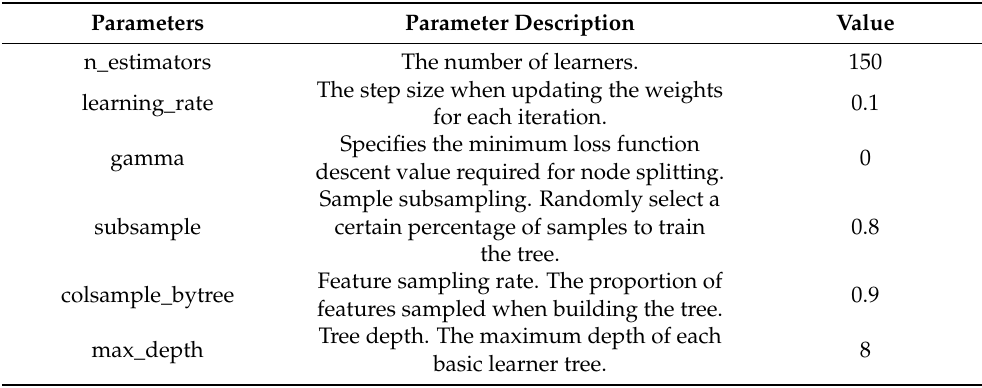
Table 2. XGBoost partial parameter setting.